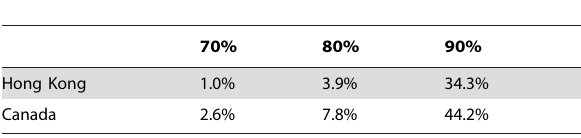
Table 2. Percentage of participants from each group who performed below three arbitrary cutoff criteria (based on Global